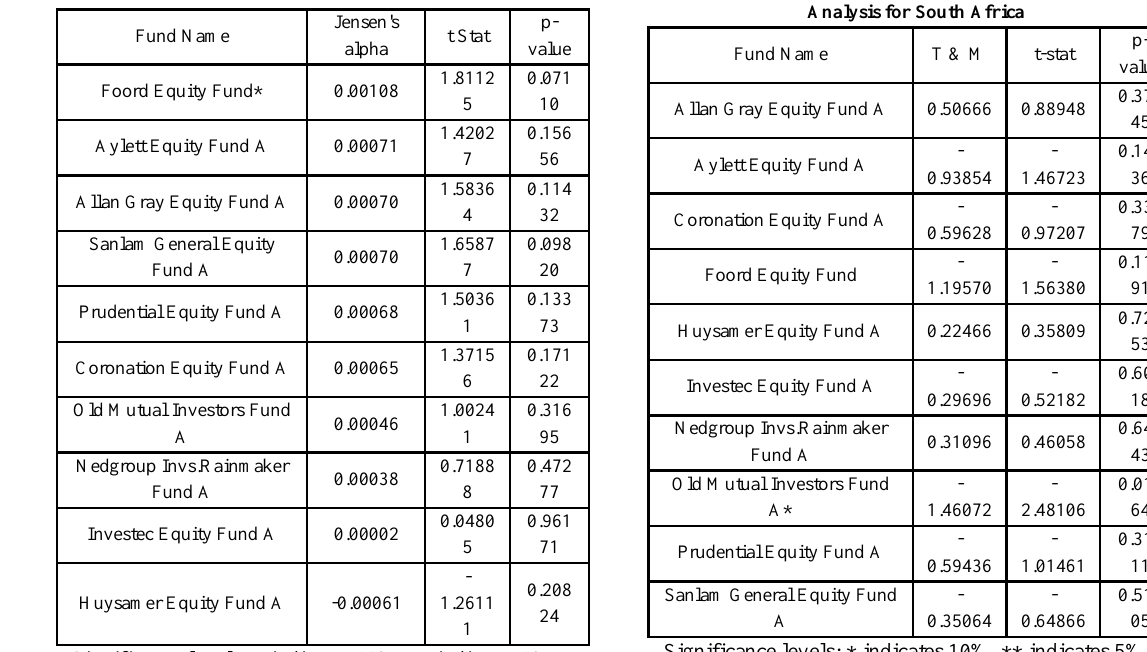
Table 5. Results of Jensen's alpha for South Africa Table 6. Results of the Treynor & Mazuy Regression